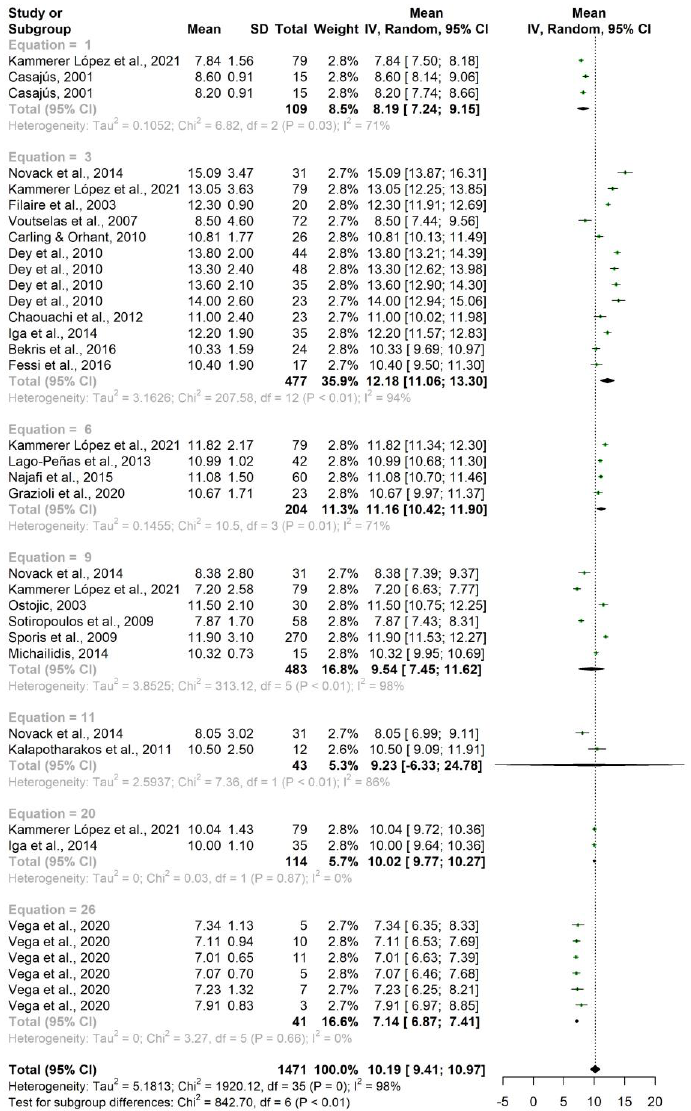
Figure 2. Forest plot fat mass percentage according to equation.